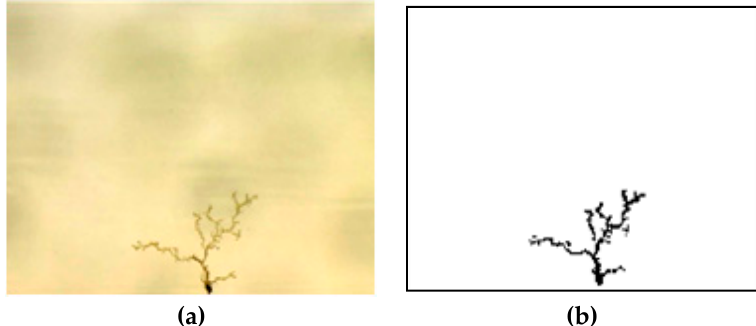
Figure 6. Example of electrical tree image binarization processing. ( a ) Electrical tree original image, ( b ) Electrical tree after image binarization processing.